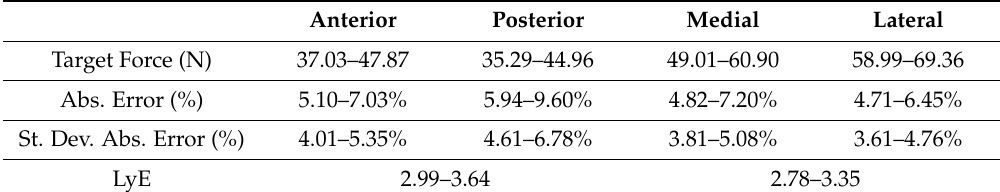
Table 2. Confidence intervals of 95% for all error calculations in all directions tested during the force control task for healthy uninjured